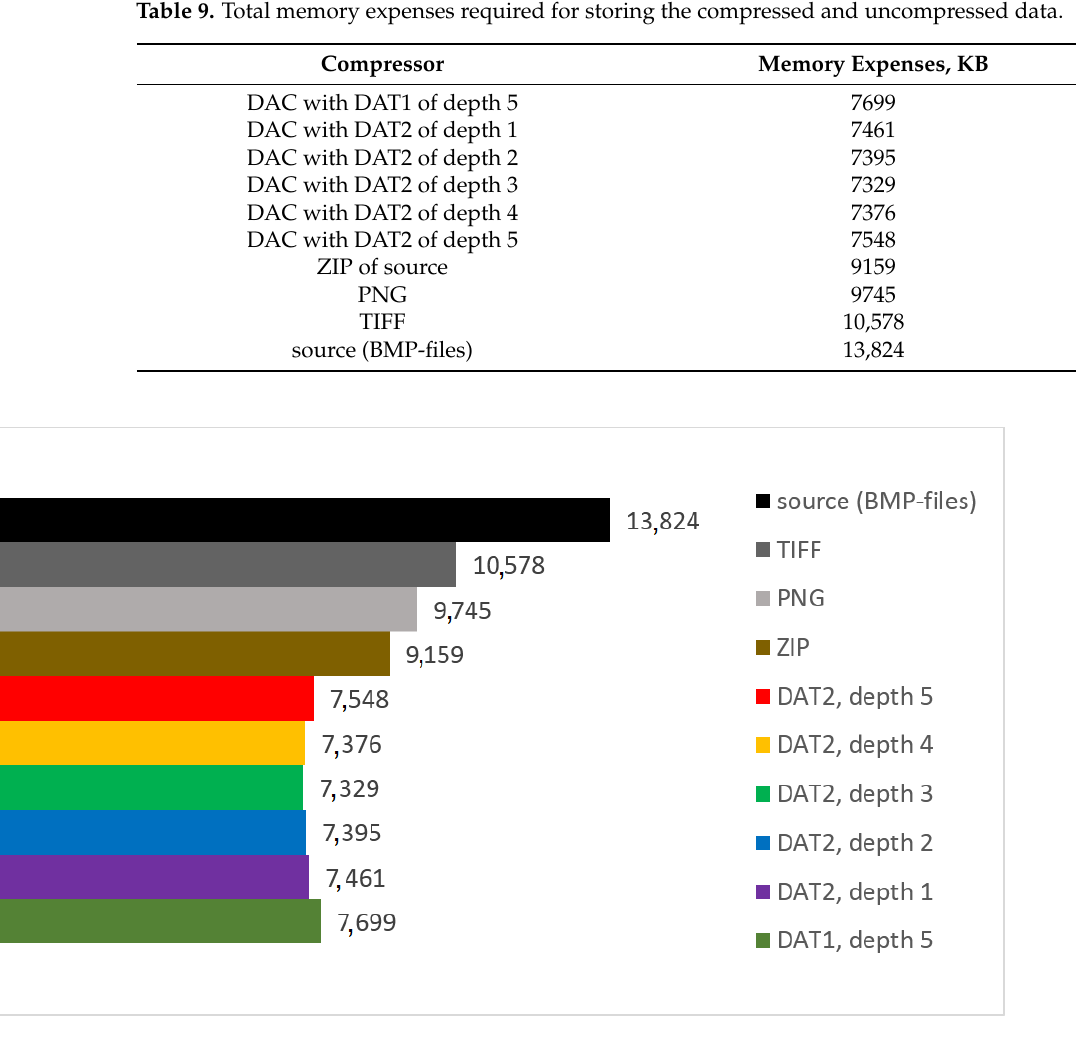
Figure 15. Total memory expenses required for storing the compressed and uncompressed data.